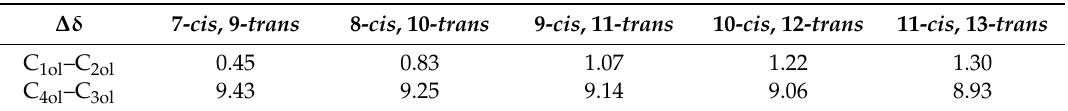
Table 15. 13 C chemical shift increments (ppm) of the olefinic carbons in several positional CLA isomers. Reprinted, with permission, from [68].